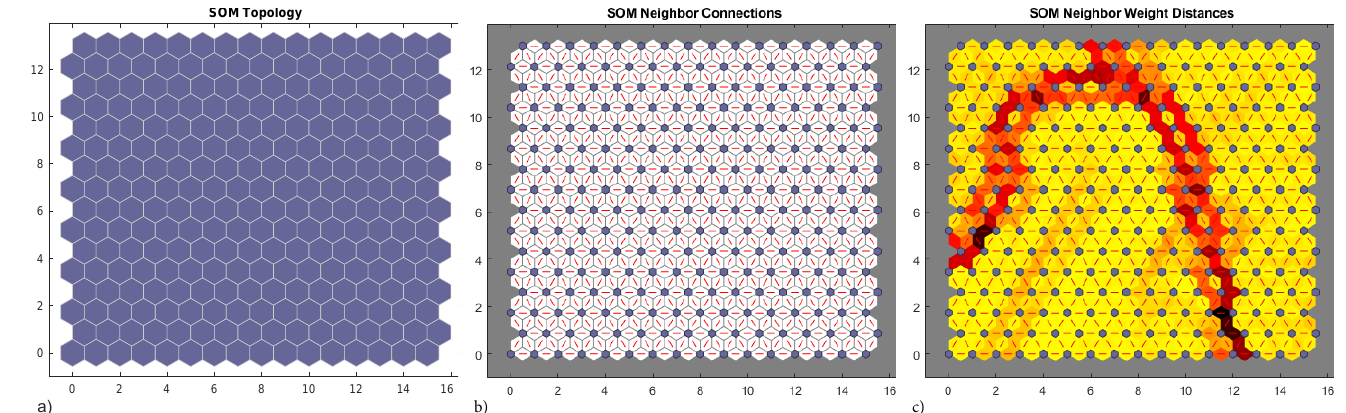
Figure 12. Neural net clustering 12,000 samples, 2D strain (cid:101) xx – (cid:101) yy . 16 ( b ) and weights ( c